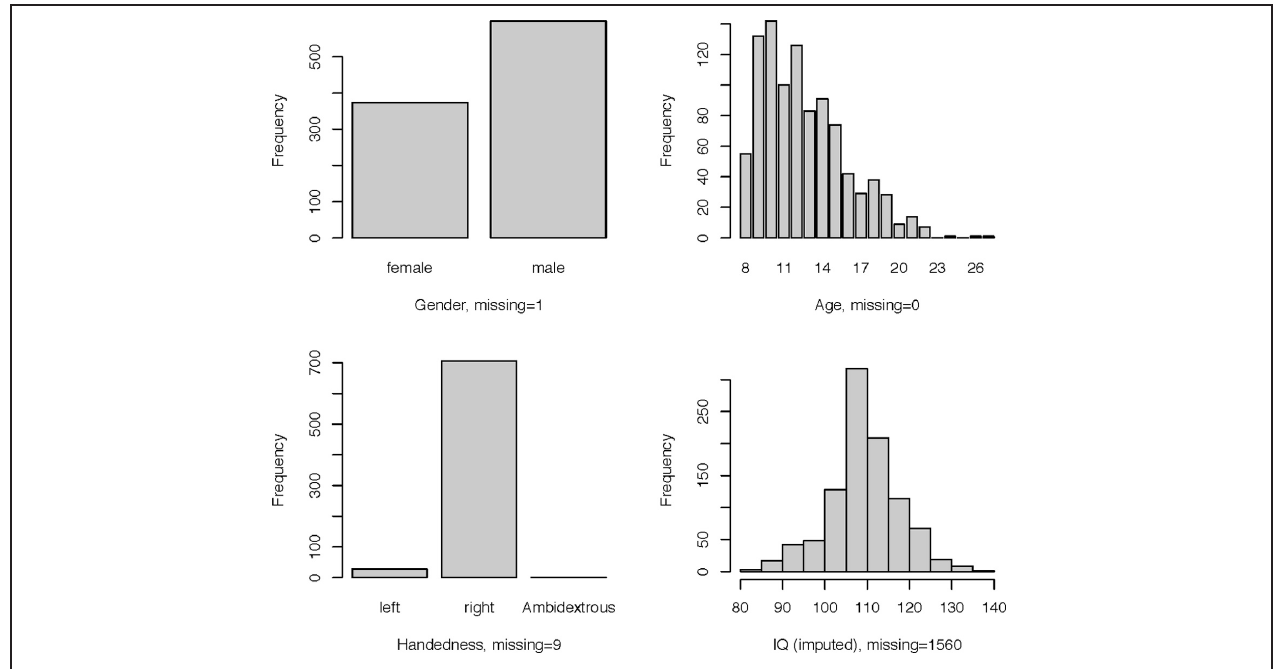
FIGURE 3 | Demographic information.